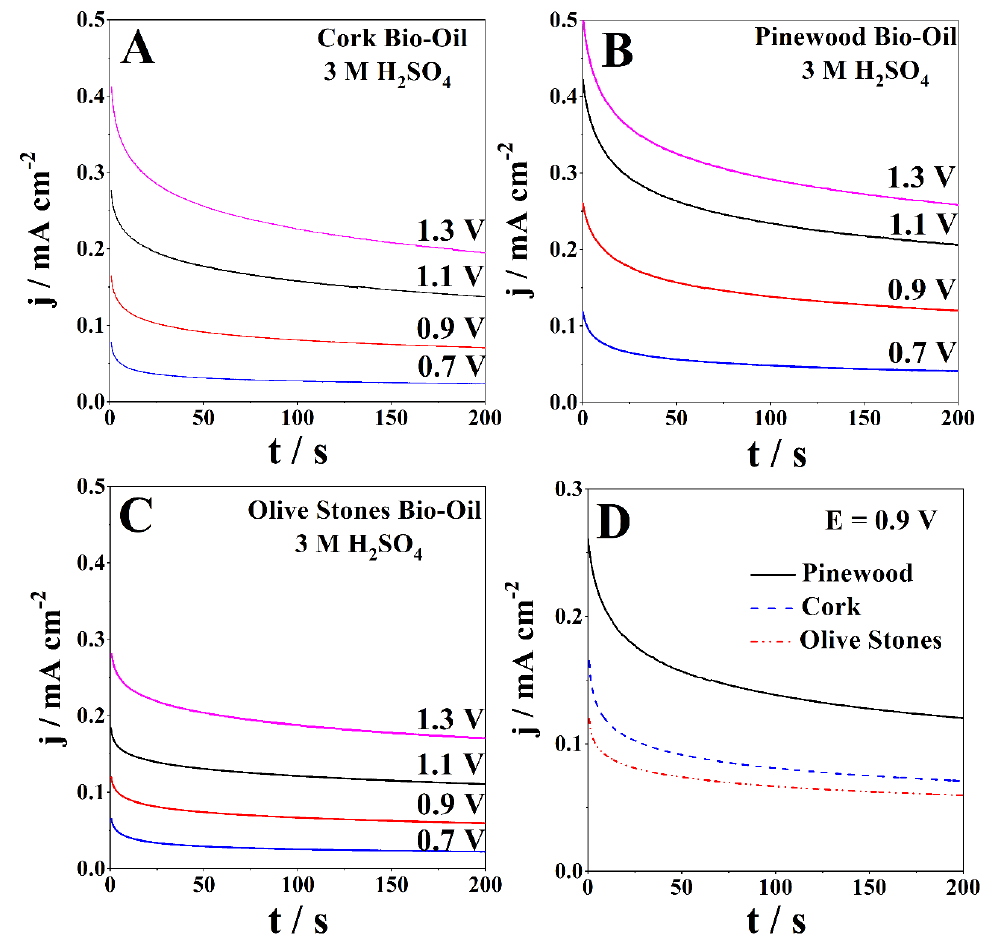
Figure 4. CAs of the samples of ( A ) cork, ( B ) pinewood, and ( C ) olive stones bio-oil with 3 M H 2 SO 4 for applied potentials ranging from 0.7 V to 1.3 V at room temperature and ( D ) direct comparison between the three different samples at 0.9 V.